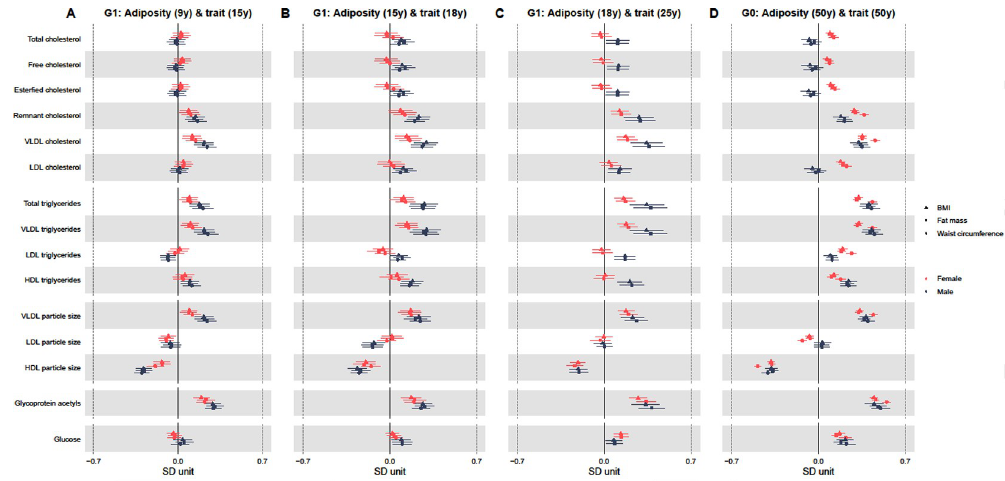
Fig 3. Sex-specific association of in BMI, fat mass, and waist circumference (per SD increase) with standardised cholesterol, triglyceride, and other trait concentrations from childhood to midlife. Results shown are standardised differences with whiskers representing 95% CIs. These represent the standardised difference in cardiometabolic trait per SD increase in BMI, fat mass, and waist circumference in each sex separately for associations of adiposity at 9 y and traits at 15